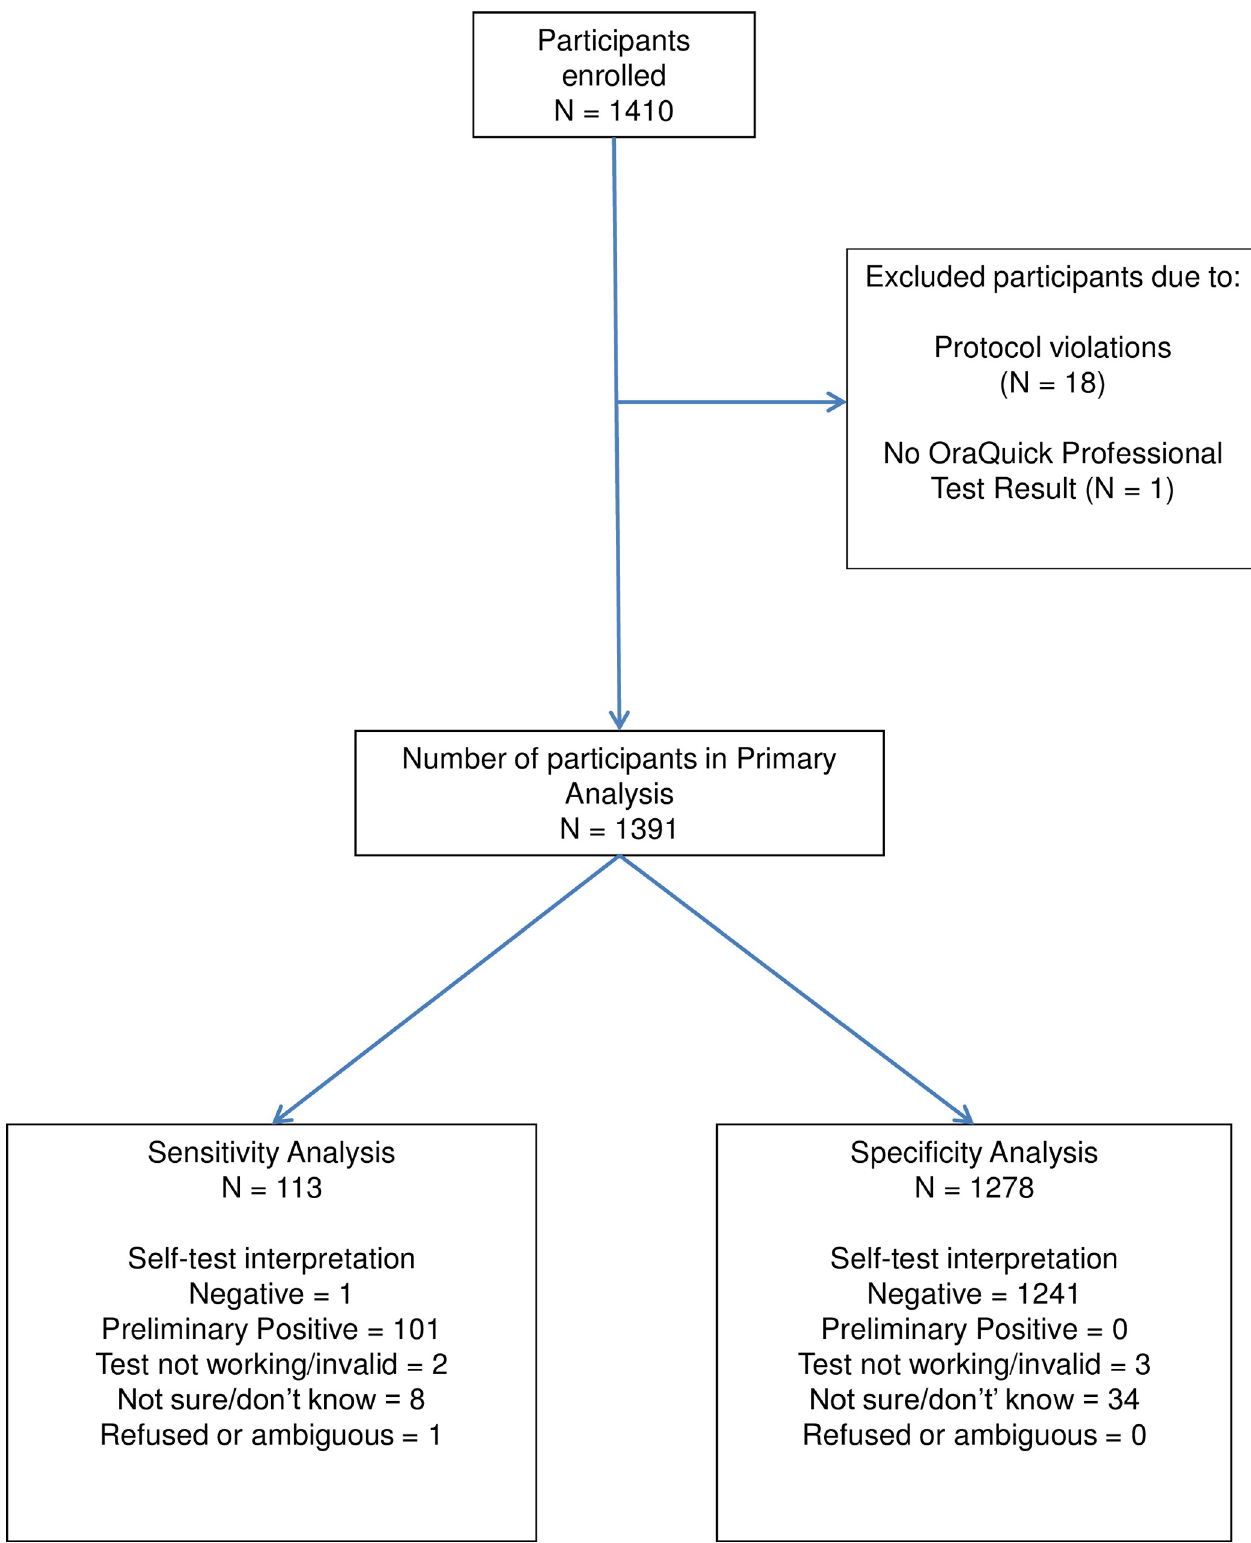
Fig 2. Study participant disposition.